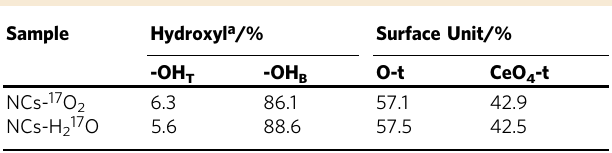
Table 2 The contents of terminal hydroxyls (-OH T and -OH B ) and different surface